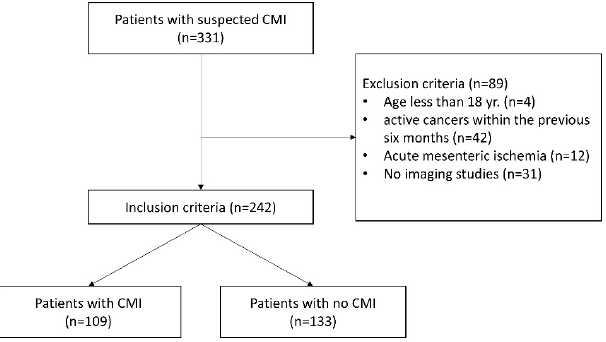
Figure 1. Flow chart showing patient inclusion and study screening process. All individuals had undergone an abdominal computed tomography angiography (CTA) using multidetector computed tomography (MDCT). To develop and calculate the new score, we retrospectively analyzed the CTA of all patients using a set of advanced postprocessing techniques and quantitative vessel analysis (QVA), including multiplanar reconstruction (MPR), curved planar reformation (CPR), and volume rendering (VR). If the measurement of the stenosis grade was not otherwise suitable, centerline analysis was performed. Two experienced surgeons independently evaluated the visceral arteries of all patients and calculated the new score for every patient based on the measurements on the CTA images. Measurements of the stenosis and calculating the score were entirely inde- pendent of the categorization according to CMI and were not used for multidisciplinary consensus decision making during the study period. 2.2. Definitions In the current study, CMI was defined as insufficient blood supply to the gastroin- testinal tract leading to ischemic symptoms with a duration of at least three months [4]. In addition, postprandial abdominal pain was defined as abdominal pain occurring within 15 to 30 min after eating. Moreover, endovascular treatment failure was defined as failed recanalization of the target visceral vessels, and recurrent stenosis after endovascu- lar treatment was defined as the development of restenosis after technically and clinically successful recanalization of a visceral artery. 2.3. The New Classification Visceral artery stenosis was determined based on CT angiography analysis according to the extent of stenosis (ostial, proximal, and extended stenosis) and the grade of stenosis (0–50%, 51–70%, 71–99%, and occlusion). Ostial stenosis was defined as stenosis of the visceral artery within the first 10 mm from the aortic lumen. The proximal lesion repre- sents stenosis into the arterial segment extending from the aortic lumen to the origin of the inferior pancreaticoduodenal artery (IPDA), the first branch of the superior mesenteric artery (SMA), and from the aortic lumen to the bifurcation of the celiac artery (CA). Ex- tended stenosis was defined as stenosis extending beyond the SMA’s first branch and the celiac artery’s bifurcation. Only ostial stenosis was considered regarding the inferior mes- enteric artery (IMA). The new classification attributes a scale from 0 to 3 for the extent of the lesions (none, ostial, proximal, and extended stenosis) and the maximum stenosis grade (0–50%, 51–70%, 71–99%, and occlusion), as described in Figure 2.